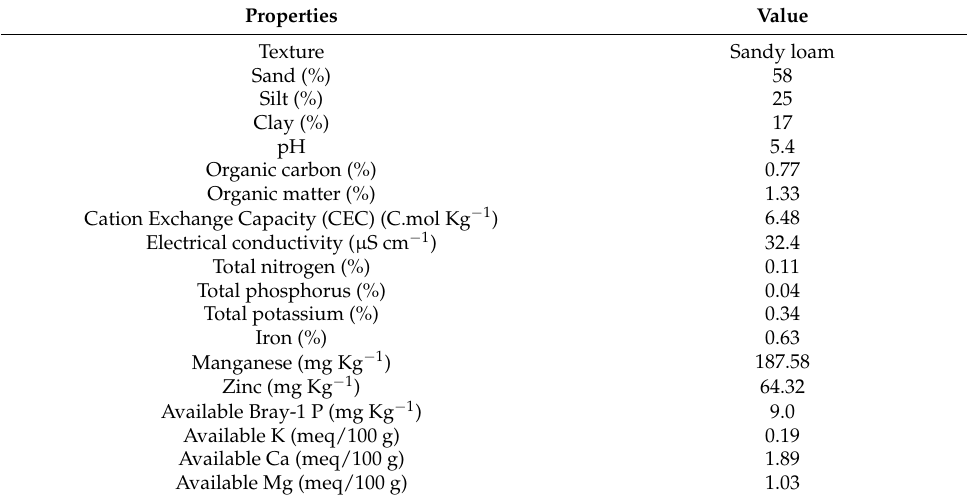
Table 2. Physicochemical properties of soil used for pot